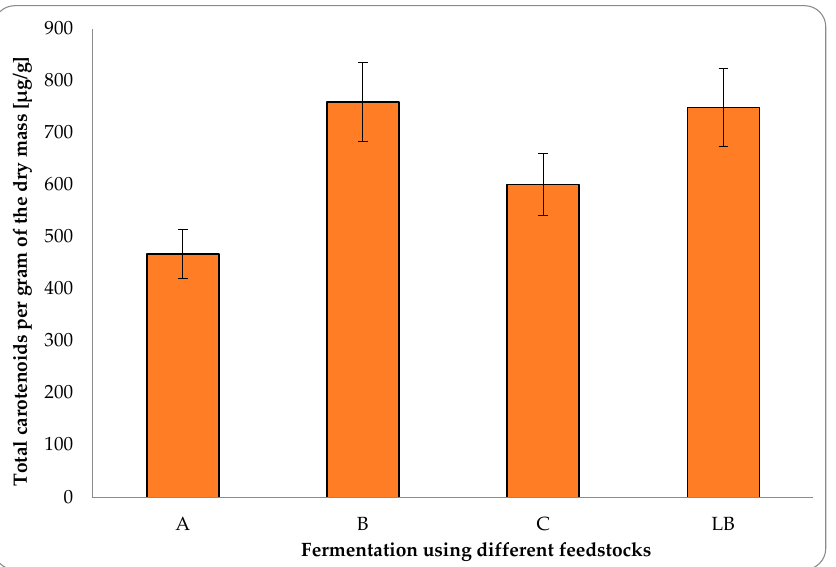
Figure 7. Total carotenoids achieved using P. kondratievae CRT2 cultivated in different media: A (based on NaOH-pretreated wheat straw hydrolysate), B (based on NaOH-pretreated sawdust hydrolysate), C (based on microwave-assisted Ca(OH) 2 -pretreated sawdust hydrolysate), and LB medium after 72 h of incubation.